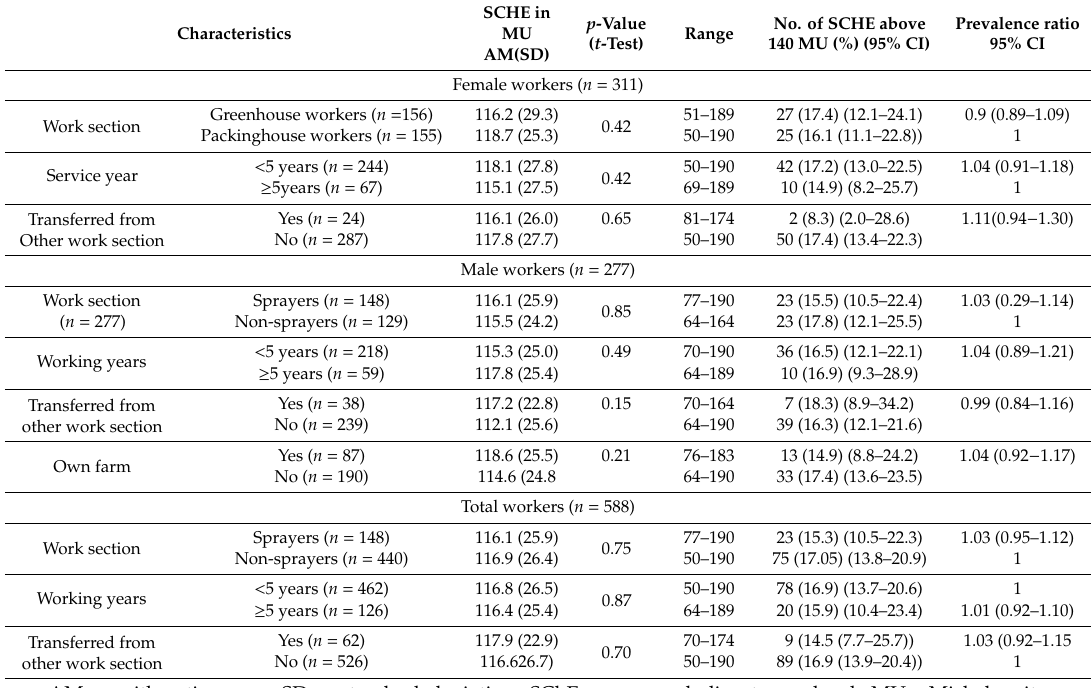
Table 3. Serum cholinesterase (SChE) level of workers with respect to di ff erent working sections among males, females and the total number of flower farm